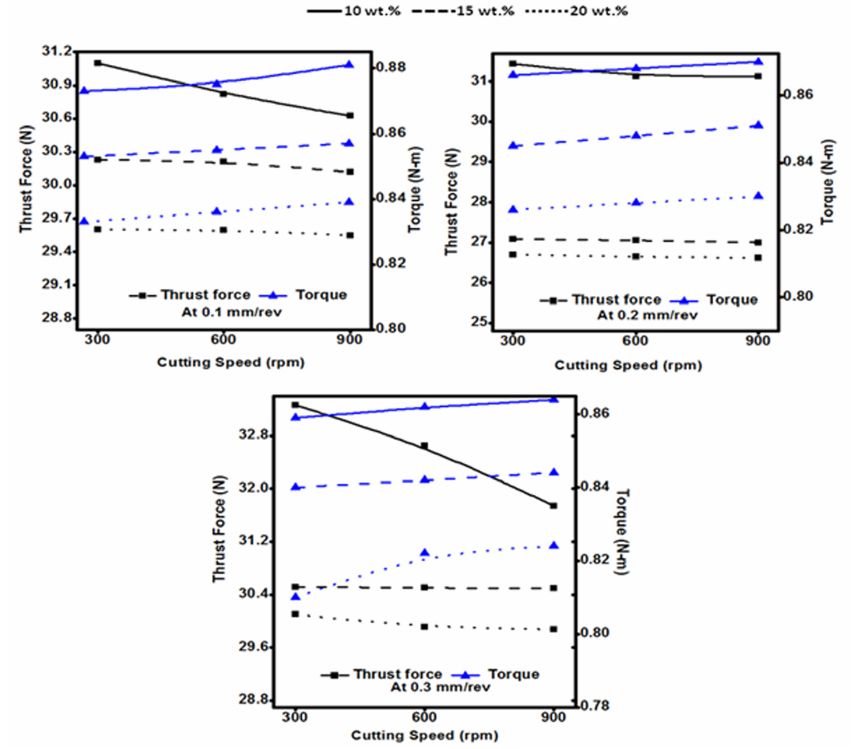
Figure 6: Effect of cutting speed, wt.% and feed rate on thrust force and torque for Particle RH reinforced composites Table 3: ANOVA data for thrust force and torque for RH reinforced Composite ANOVA analysis for thrust